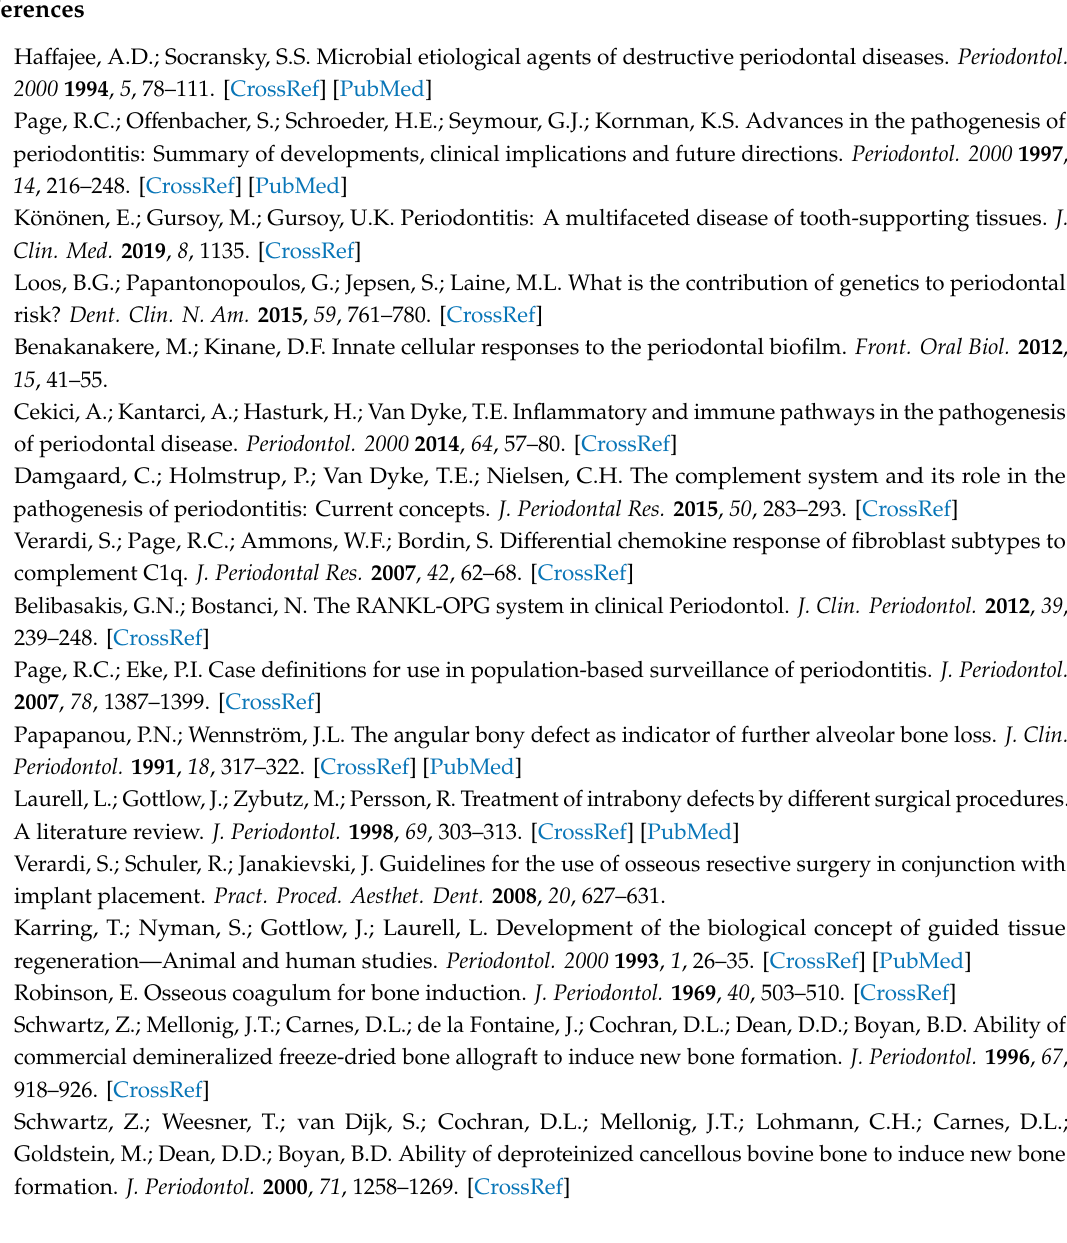
Table S1: Distribution of treated sites and clinical